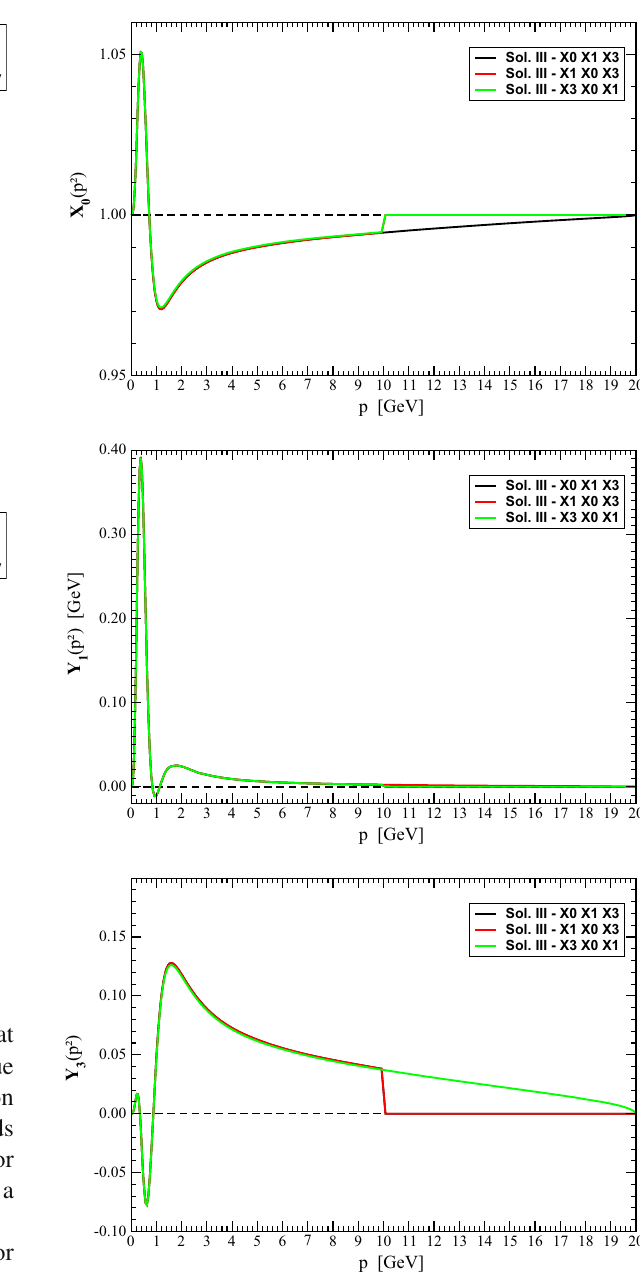
Fig. 23 X ( 0 ) ( p 2 ) , Y 1 ( p 2 ) and Y 3 ( p 2 ) computed from inverting the Dyson–Schwingerequations(Sol.III)afterbuildthelargelinearsystem (78) in all possible ways, i.e. by permuting the role of the form factors in X . See text for